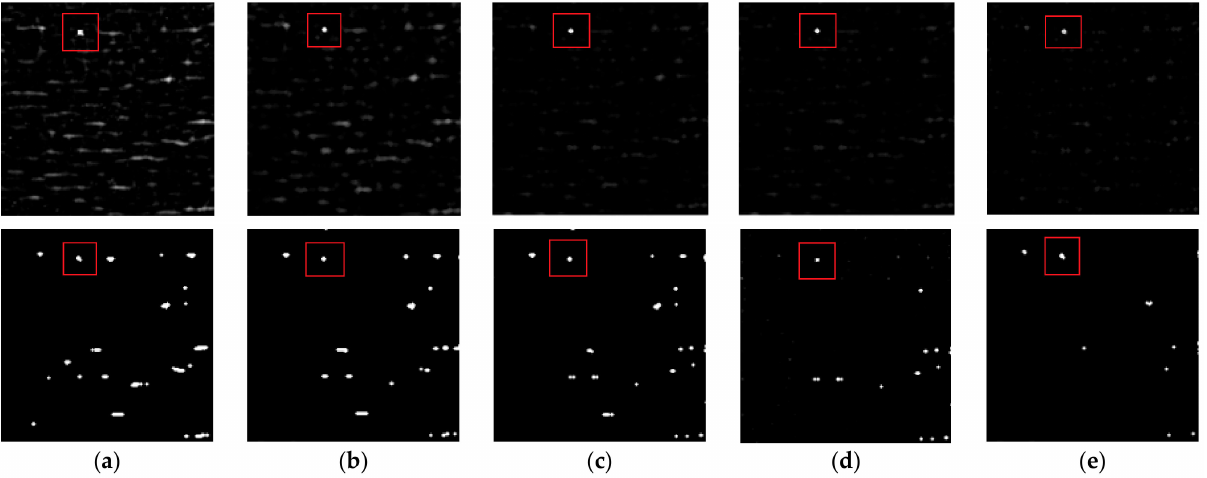
Figure 15. Strongly undulating sea clutter. ( a ) Top-hat. ( b ) Spatial dynamics. ( c ) Temporal dynamics. ( d ) Spatio-temporal filter. ( e ) Proposed algorithm.